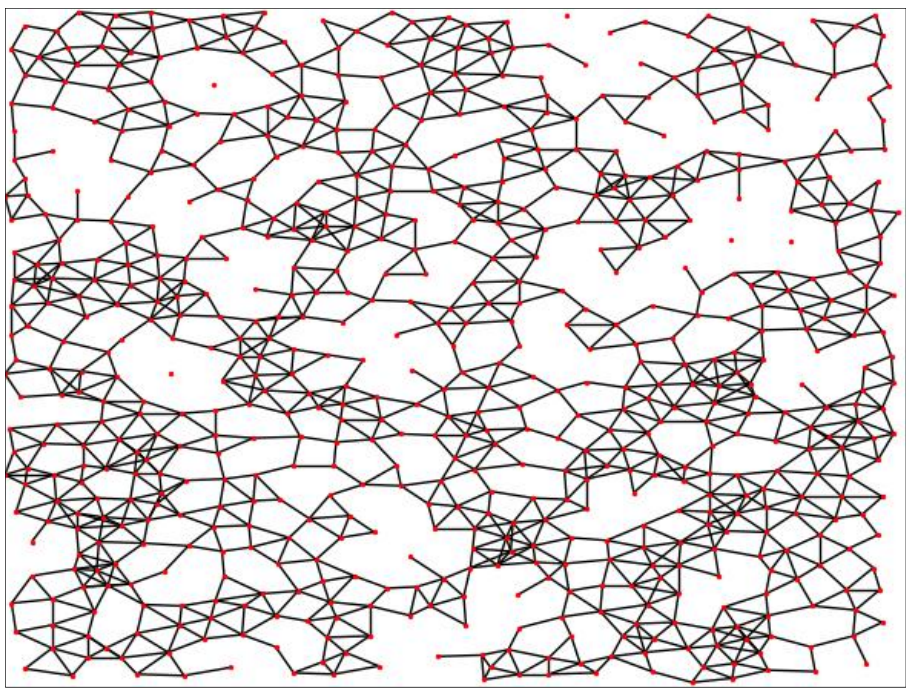
Figure 4. The geochemical topology graph in the study area. Red dot—the graph node; black line—edge.